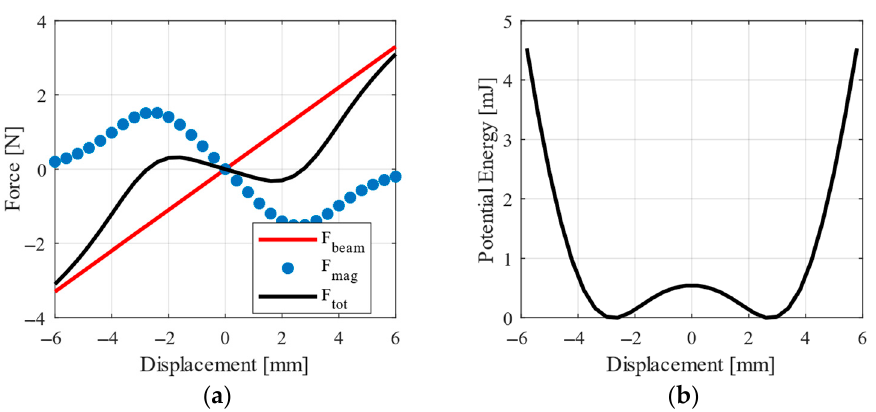
Figure 11. ( a ) Final stiffness force and ( b ) potential energy of the designed oscillator.